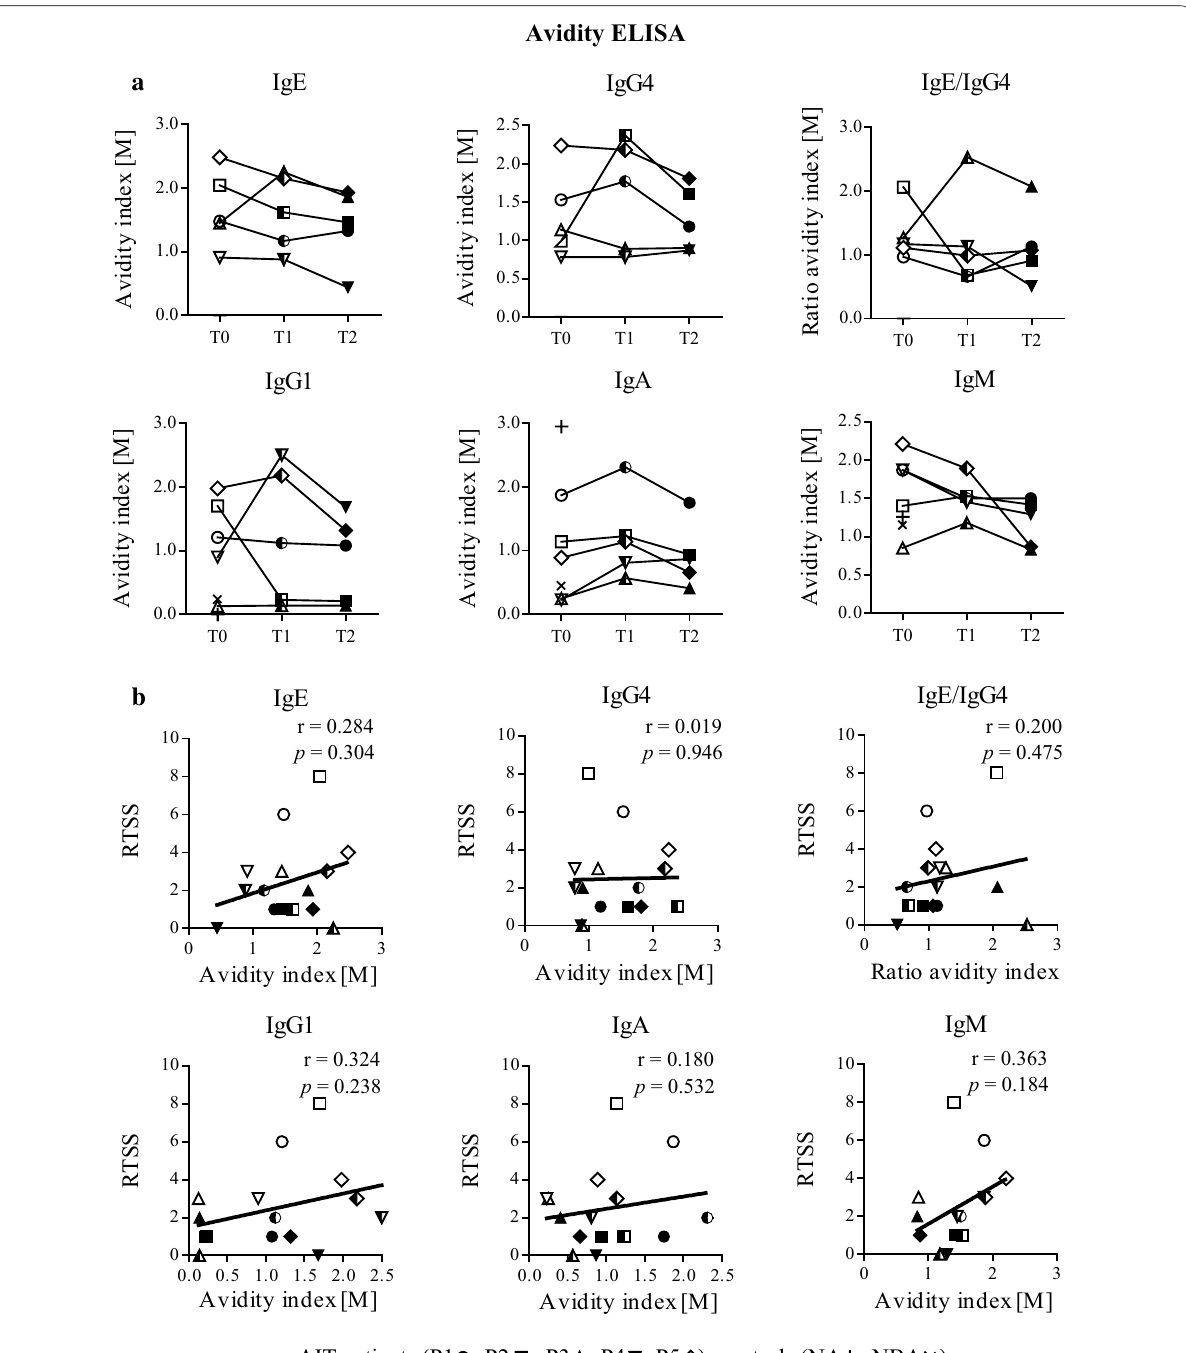
Fig. 5 Bet v 1-specific serum antibody avidities during AIT and in control sera analyzed by ELISA. a Therapy-related changes in antibody subclass avidity indices. Statistics were performed with Friedman and Dunn’s post test. b Correlation of antibody avidity indices with RTSS. Serum samples were obtained at three different time points (T0, open; T1, semi-filled; T2, filled